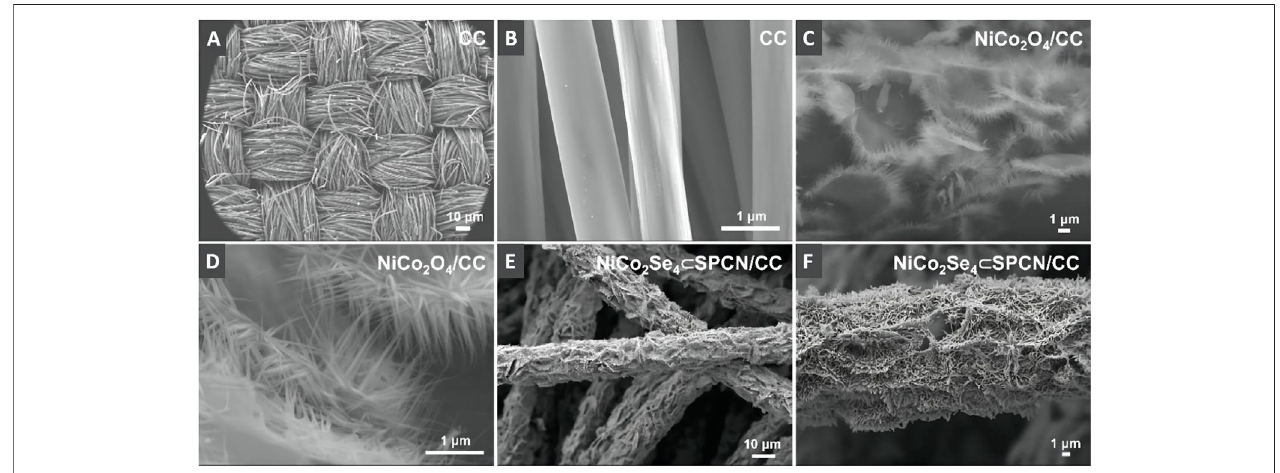
FIGURE 2 | SEM images for the (A,B) pure CC (C,D) NiCo 2 O 4 /CC, and (E,F) NiCo 2 Se 4 ⊂